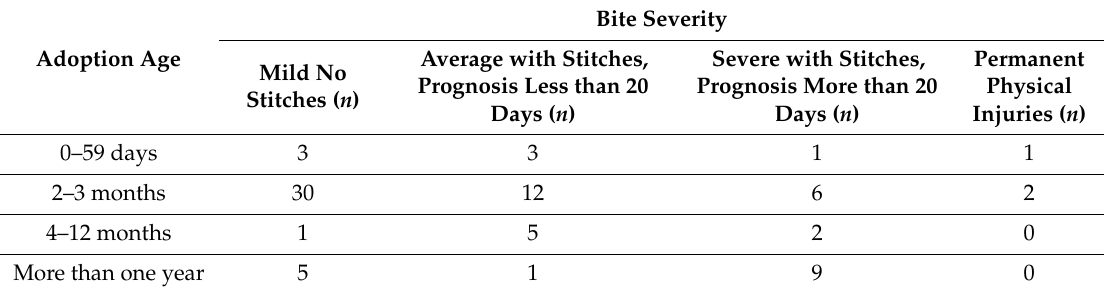
Table 17. Comparisons between dog adoption age and bite severity in dog–human aggression episodes.